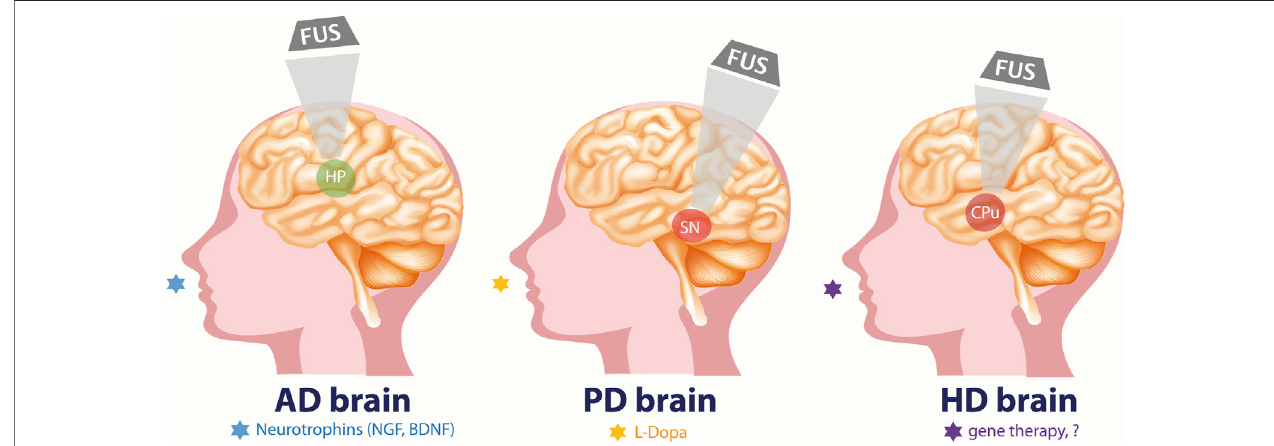
FIGURE 3 | FUS-aided, non-invasive brain delivery of novel or repurposed drugs, as possible therapeutic application in three devastating neurodegenerative diseases of the human central nervous system, namely AD, PD and HD. Speci fi c target regions are identi fi ed and selectively reached for FUS-aided drug delivery in neuroprotective/therapeuticapproaches:hippocampus(HP)forAD,Substantianigra(SN)forPD,andCaudatePutamen(CPu)forHD.NGFandBDNFinAD,L-Dopaor dopaminergic drugs in PD, and gene therapy or currently unknown molecules are proposed for intranasal FUS-aided therapy.